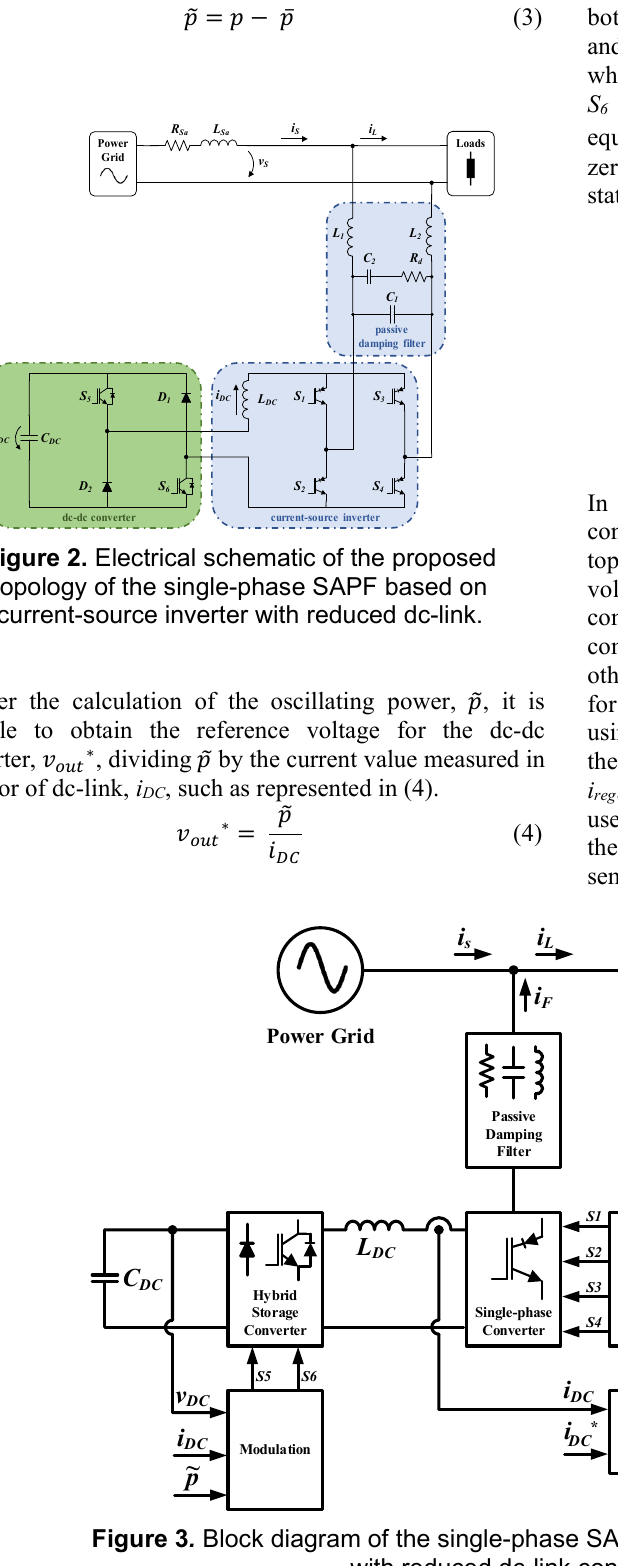
Figure 3 . Block diagram of the single-phase SAPF based on a current-source inverter with reduced dc-link control